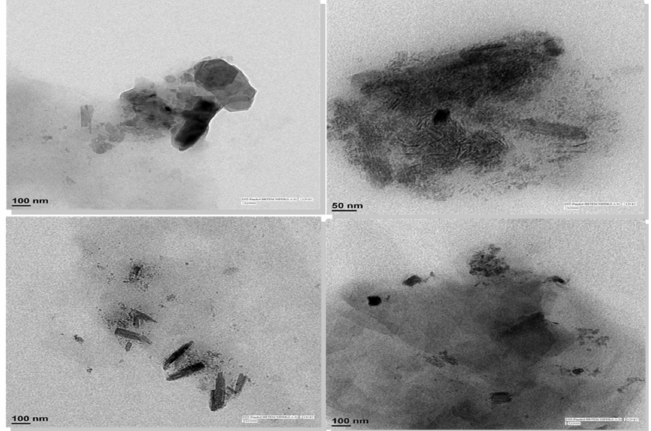
Figure 9. TEM images of CEL_NCSD dispersion showing CEL nanocrystals (dark spots) in the matrix of MAN (greyish black